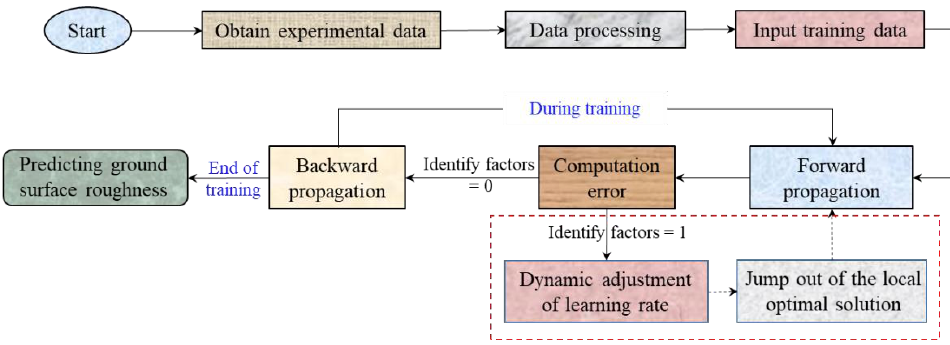
Figure 5. The process of predicting ground surface roughness.